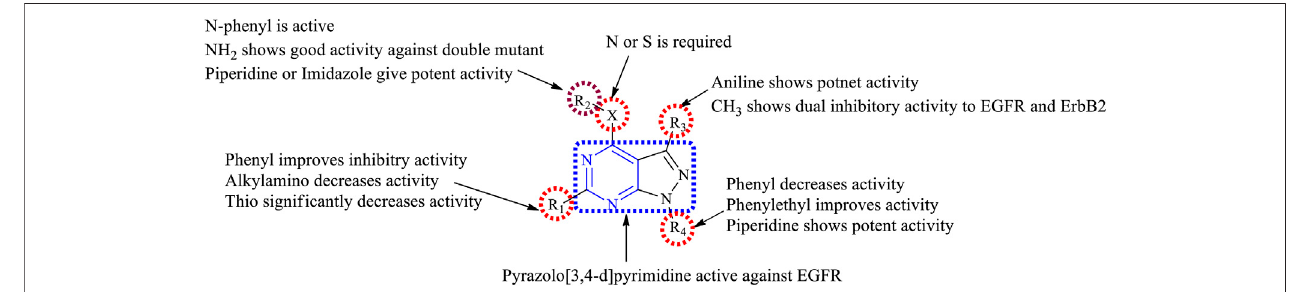
FIGURE 16 | Summary SAR of pyrazolopyrimidine.